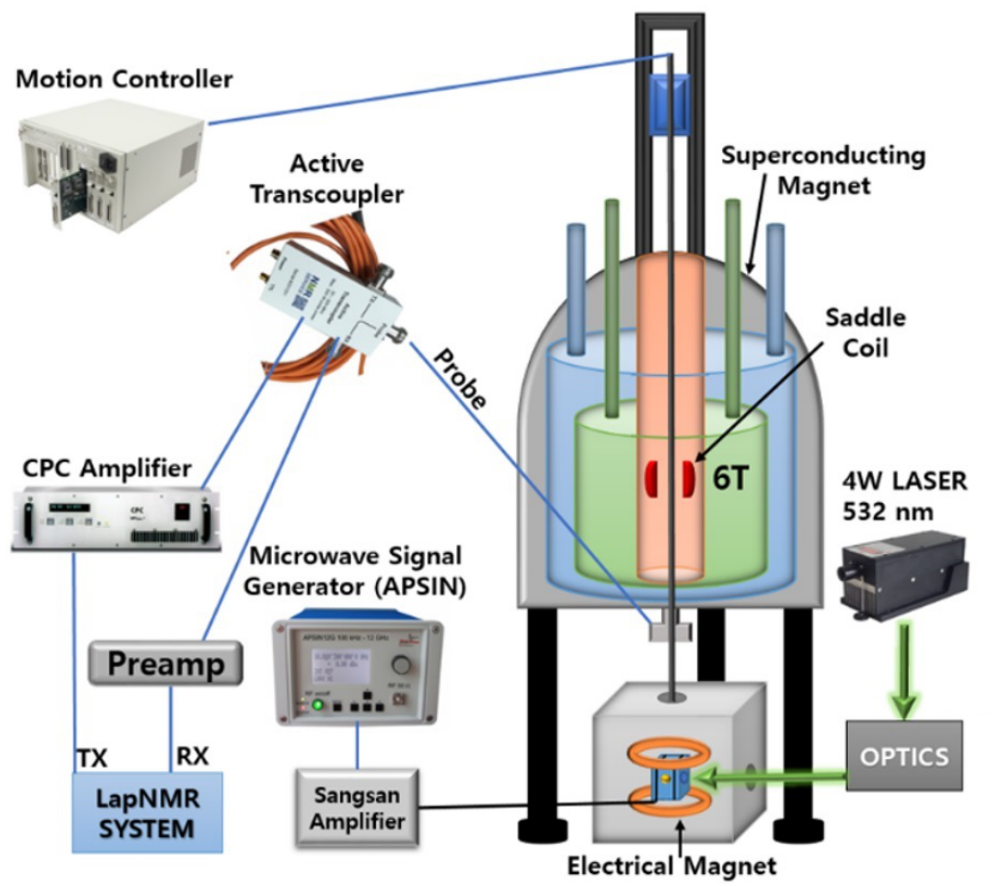
Figure A1. Full experimental